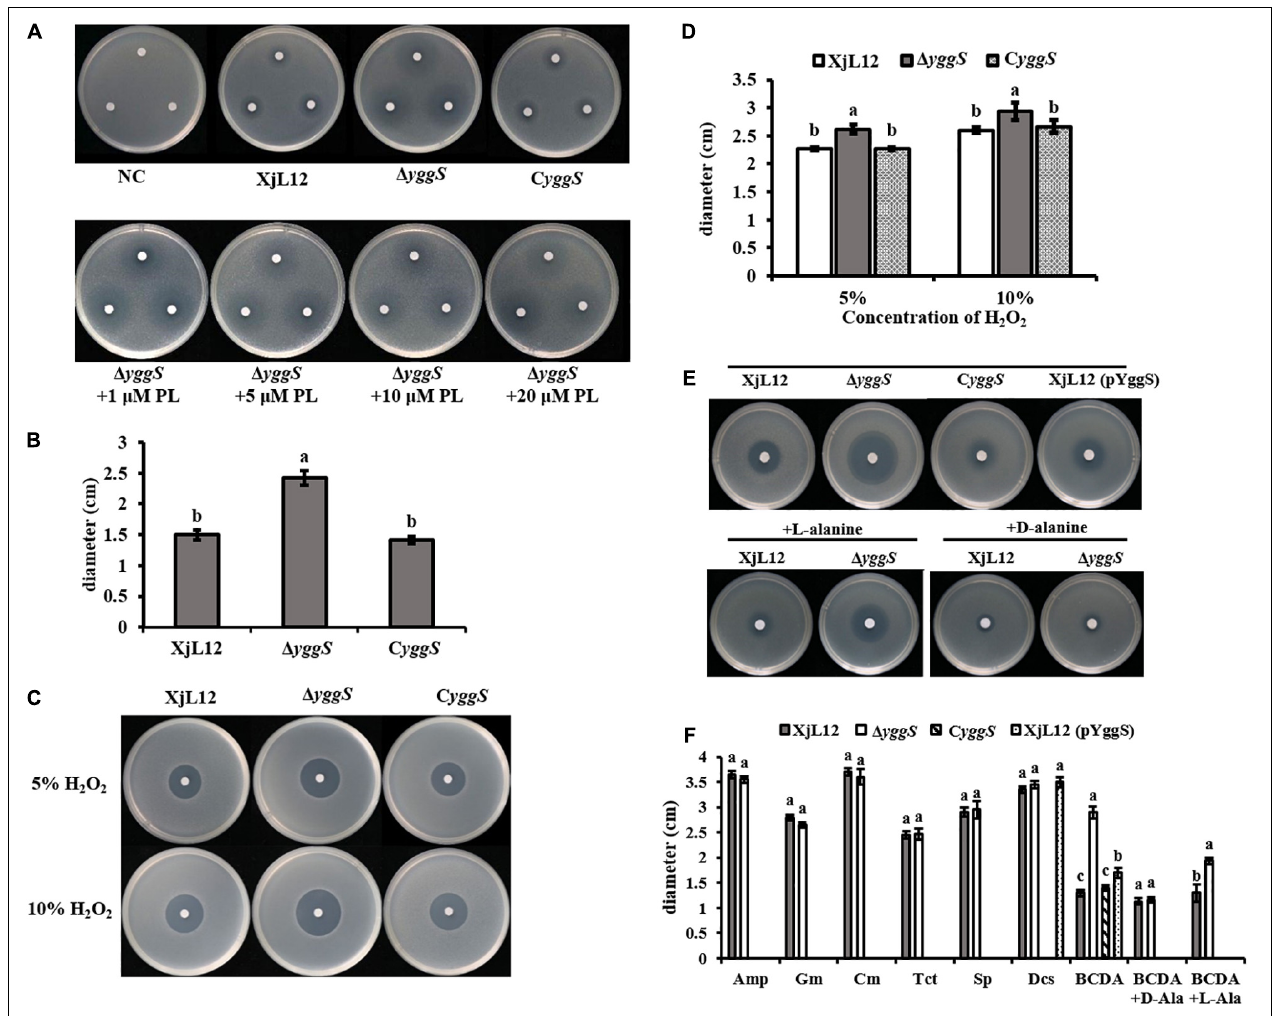
FIGURE 7 | The role of yggS in the sensitivity of Acidovorax citrulli to selected stressors. (A) The toxicity of pyridoxine (PN) (in the absence or presence of pyridoxal (PL)) to A. citrulli strains. (B) The diameter of inhibition zones caused by PN. All phenotypes were observed after incubation for 48 h. (C) Sensitivity of A. citrulli strains to H 2 O 2 . Two different concentrations of H 2 O 2 were dropped in the center of the plate containing A. citrulli strains. (D) H 2 O 2 sensitivity was measured by the diameter of the zone of bacterial growth inhibition. (E) Representative images illustrating the sensitivity of A. citrulli strains to BCDA (in the absence or presence of L-alanine or D-alanine). (F) Diameters of A. citrulli inhibition zones for each antibiotic were represented by histogram. The bars in the histogram represent mean inhibition zone and lines represent standard errors of the mean of three experiments. XjL12: wild-type strain, (cid:49) yggS : yggS deletion mutant; C yggS :